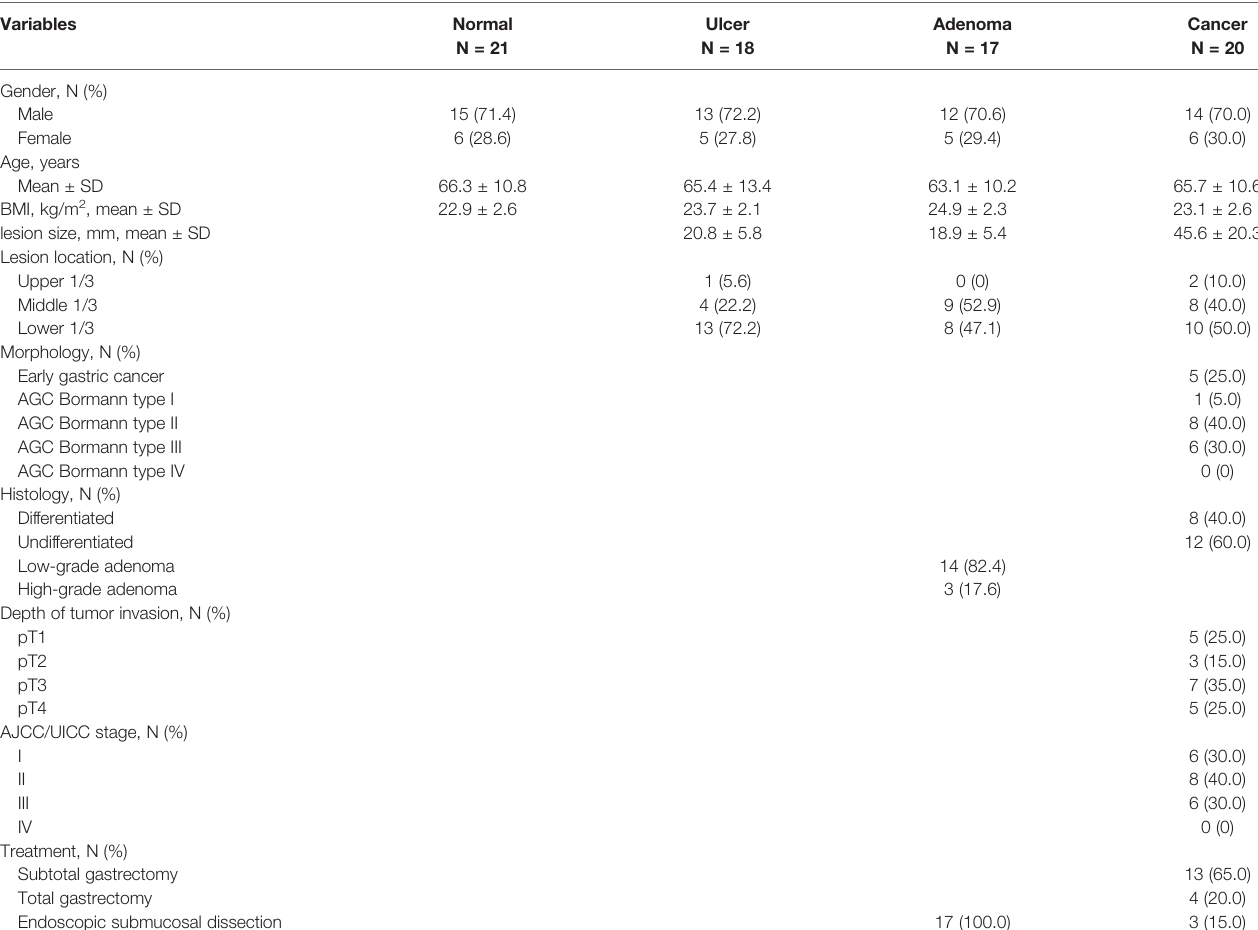
TABLE 1 | Demographics and pathologic characteristics of enrolled patients.